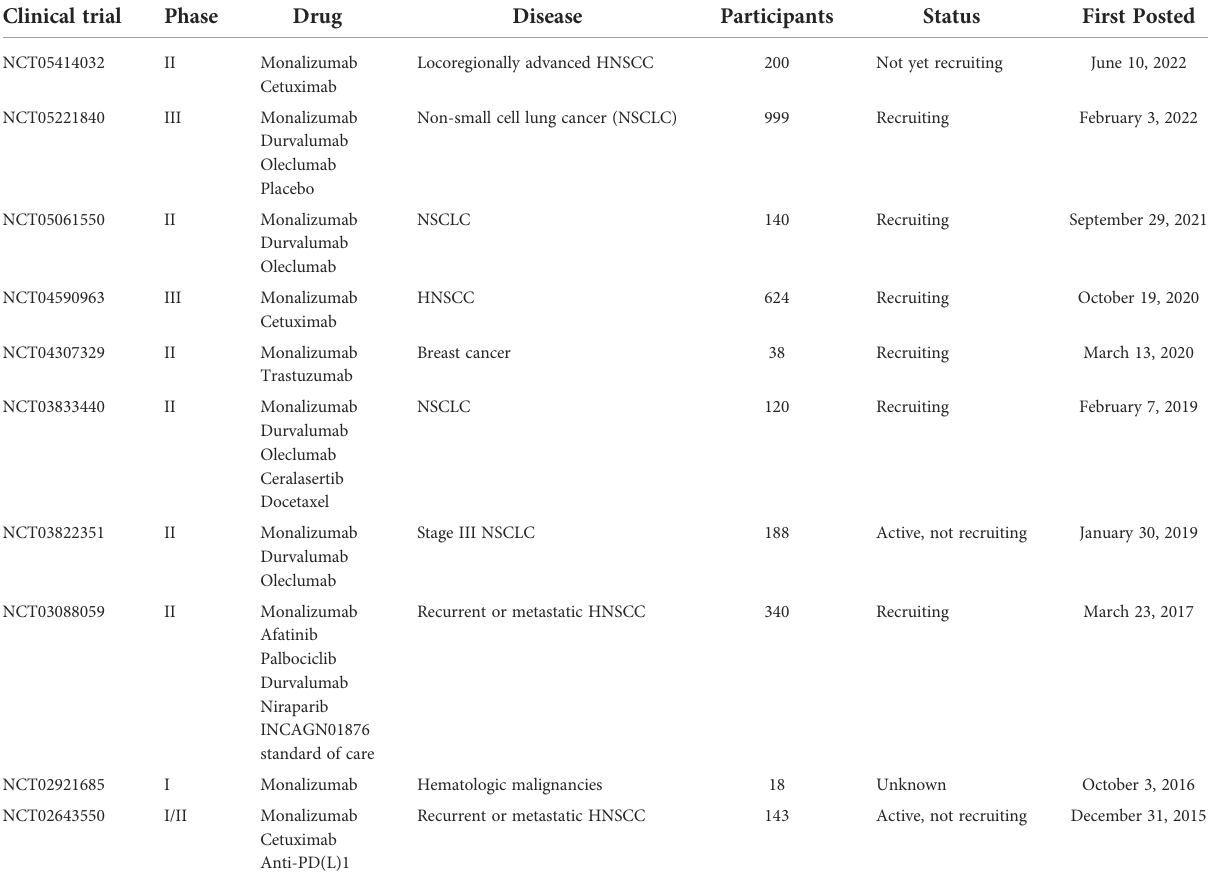
TABLE 1 Ongoing clinical trials with monalizumab for the treatment of tumors. Clinical